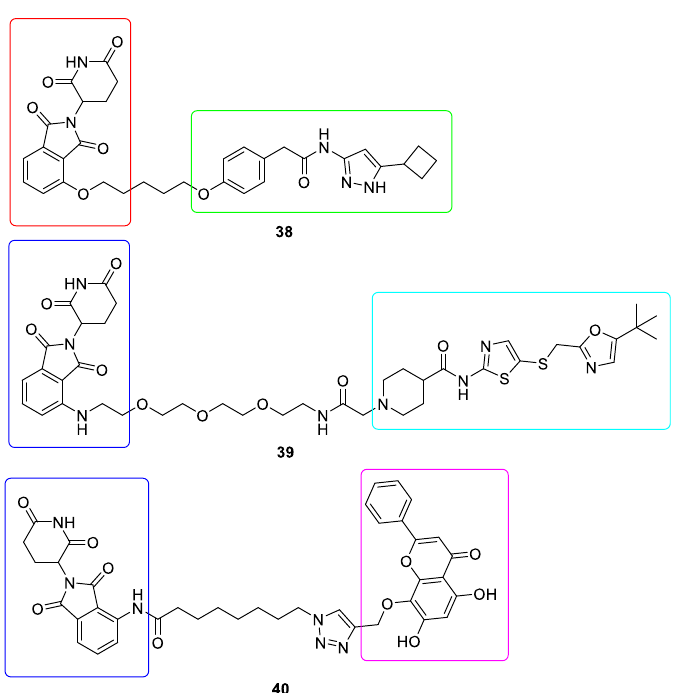
Figure 11. Chemical structures of CDK9 PROTACs. Red rectangle denotes the Thalidomide moiety, dark blue rectangle denotes the Pomalidomide moiety, green rectangle denotes the aminopyrazole derivative moiety, light blue rectangle denotes the SNS-032 moiety and violet rectangle denotes the Wogonin moiety.